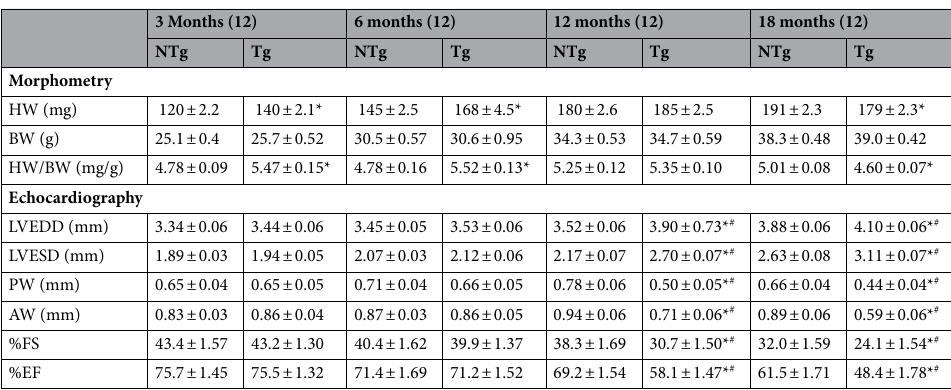
Table 1. Age-dependent Echocardiography and Morphometric parameters for NTg and miRNA-7 Tg mice. * p < 0.001 vs. NTg, # p < 0.005 vs. 3 & 6 months